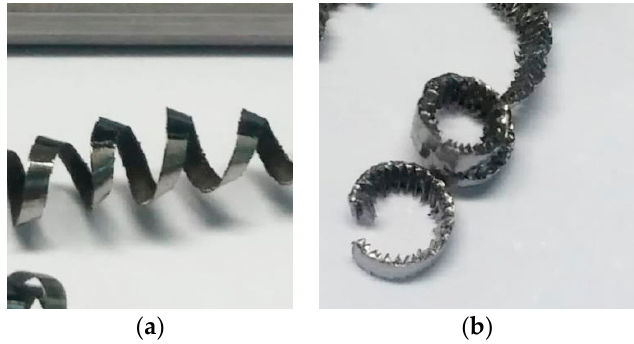
Figure 5. Chip morphology for ( a ) v c = 30 m/min, f = 0.05 mm/r, and ( b ) v c = 30 m/min, f = 0.30 mm/r.